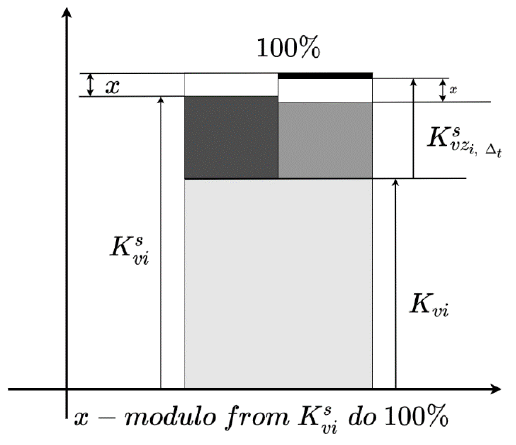
Figure 2. Schematic depiction of the calculation 𝐾 𝑣𝑖 𝑠